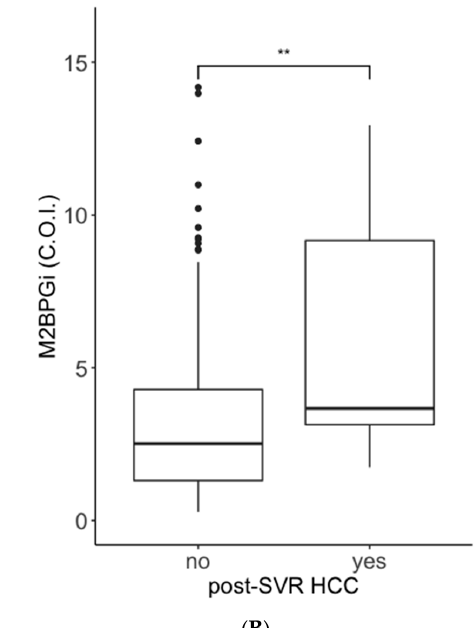
Figure 2. Comparisons of serum autotaxin (ATX) levels in patients with and without post-SVR HCC development. Data from Cohort B were used for the analysis. Data from male patients ( A , C ) and female patients ( B , D ) are shown. A and B indicate pretreatment levels, and C and D indicate those at 12/24 weeks after antiviral treatment. Boxes represent the interquartile range of the data. The horizontal lines in the boxes indicate the median values. The vertical lines connect the nearest values of 1.5 times the interquartile range from the quartile points. The dots indicate outliers. **: p < 0.01; ***: p < 0.001. ATX: autotaxin; SVR: sustained viral response; HCC: hepatocellular carcinoma.